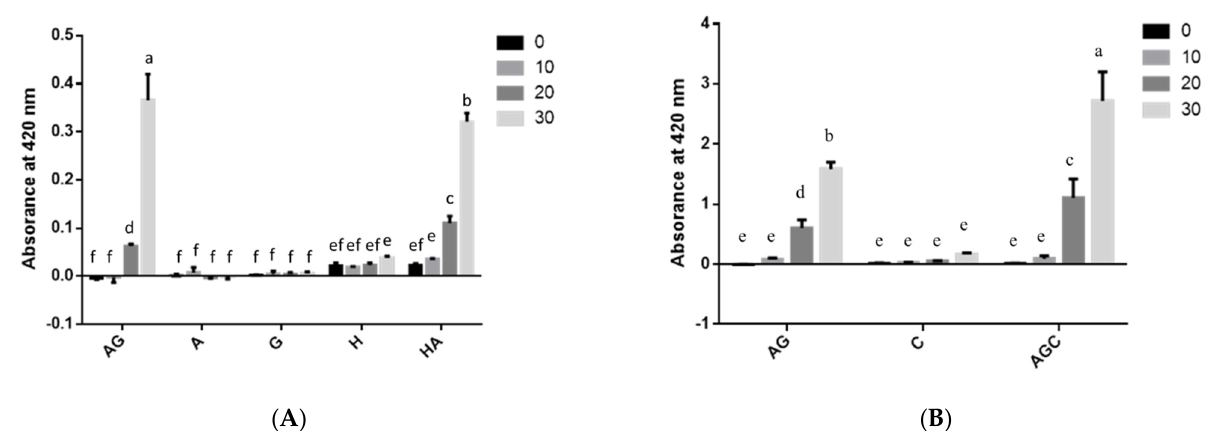
Figure 2. The absorbance at 420 nm of different groups in: ( A ) deionized water and ( B ) acetic acid at various heated processing duration. AG: asparagine + glucose; A: asparagine; G: glucose; H: hydroxymethylfurfural; HA: hydroxymethylfurfural + asparagine; C: chitosan; AGC: asparagine + glucose + chitosan. Values are expressed as mean ± standard deviation (SD) ( n = 3). a–f Indicate significant differences between different groups ( p < 0.05).